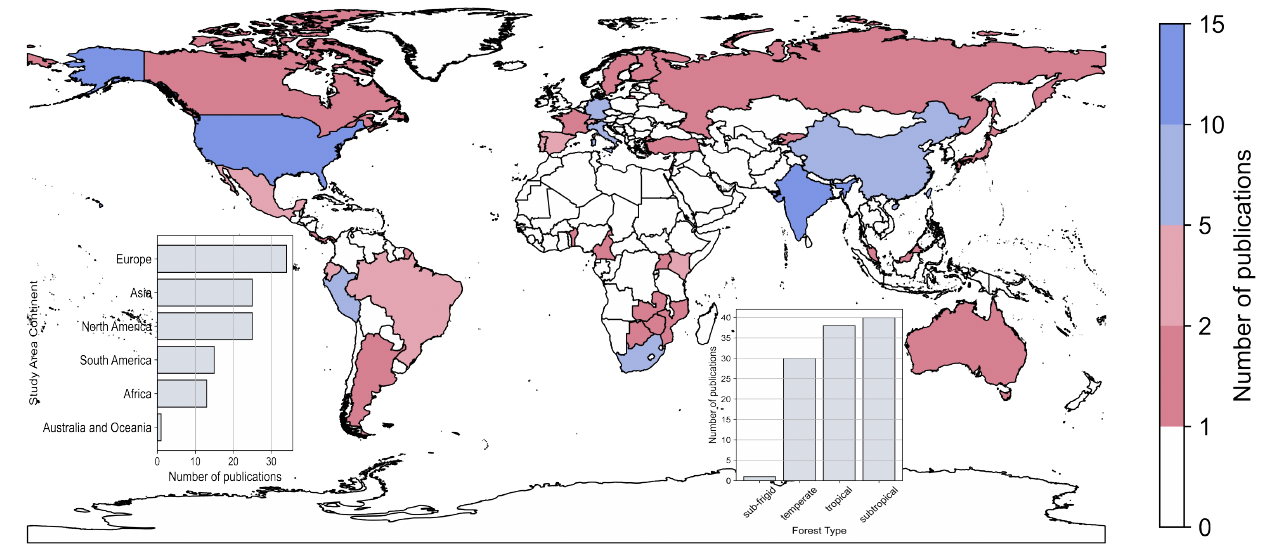
Figure 6. Map of the spatial distribution of study areas at country level, which is why three studies at European coverage and one study covering North America are not displayed in the map. Europe is the continent with the highest number of publications (34 publications, including the three studies with the study area being Europe). Asia and North America present the same number of publications (25 publications, including one study with the study area being North America). Additionally, the study areas have been classified according to the forest types assessed in Xu et al. 2022 [86]: temperate (30 publications), tropical (38 publications) and subtropical forests (40 publications) present rather close publication numbers compared to only one study on sub-frigid forests [87]. The color bar on the right displays the number of publications in five categorical